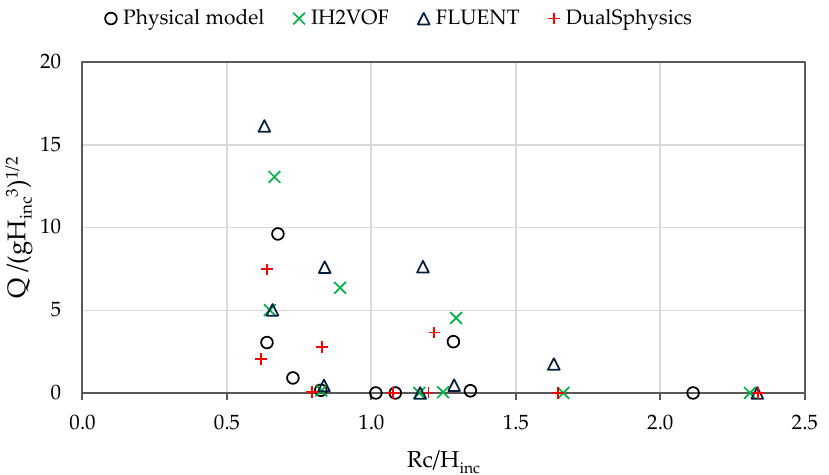
Figure 16. Dimensionless mean wave overtopping discharge as function of relative freeboard, for cases 1 to 9.